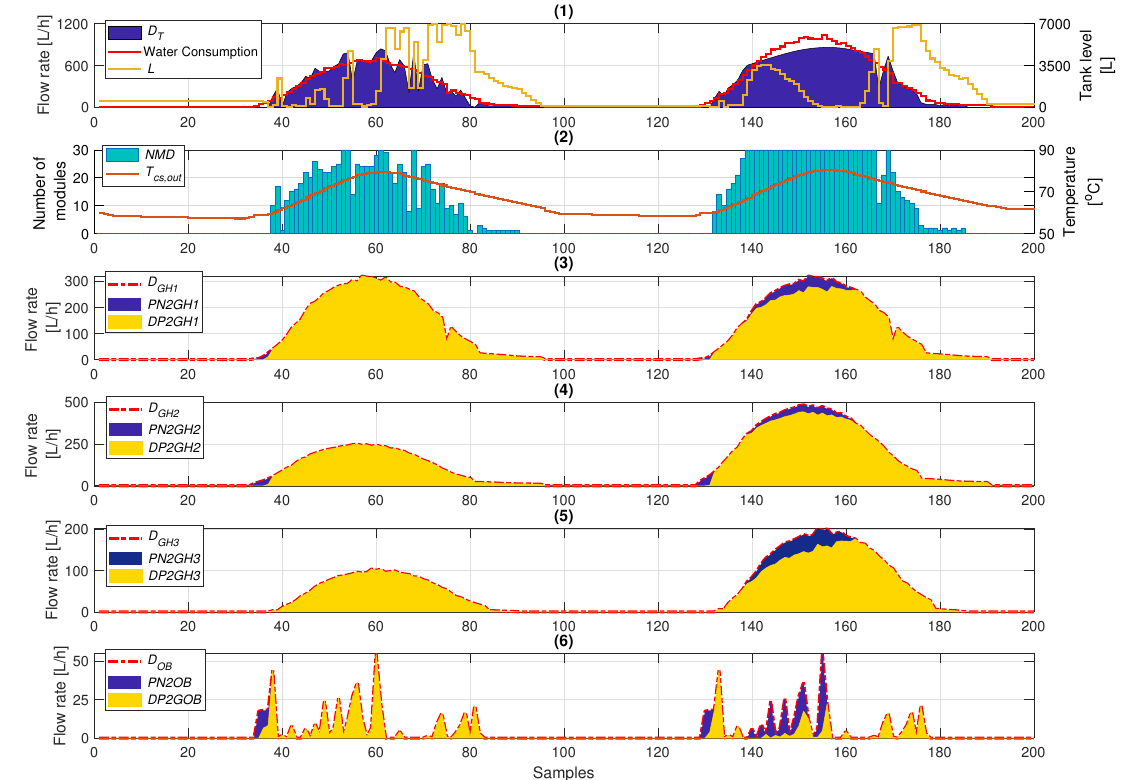
Figure 5. Simulation results. All the variables are according to Appendix